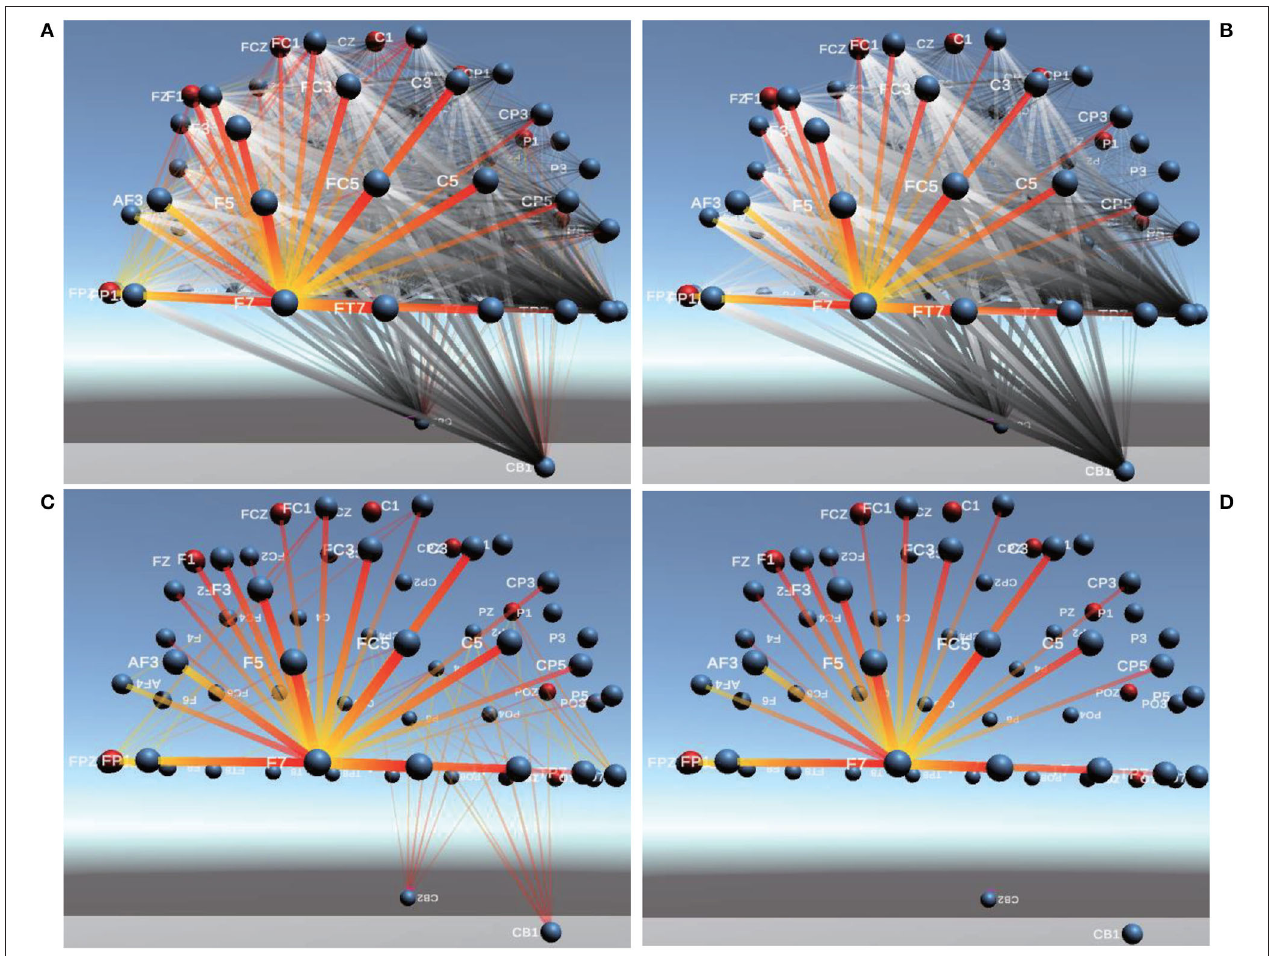
FIGURE 9 | Comparable Connectivity Visualization of PCC and Comprehensive. (A,B) are Comparable Connectivity Visualization of PCC and Comprehensive. (C,D) are Comparable Connectivity Visualization of 1/2 of PCC and